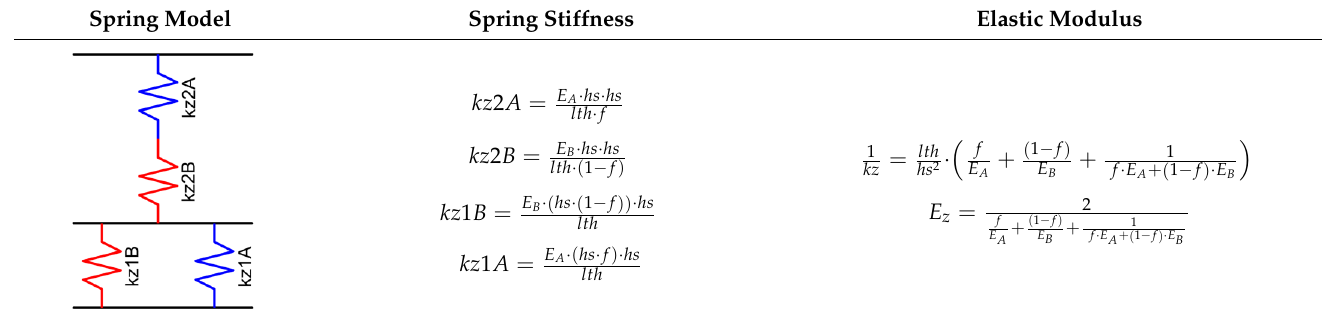
Table 3. Cont. Spring Model Spring